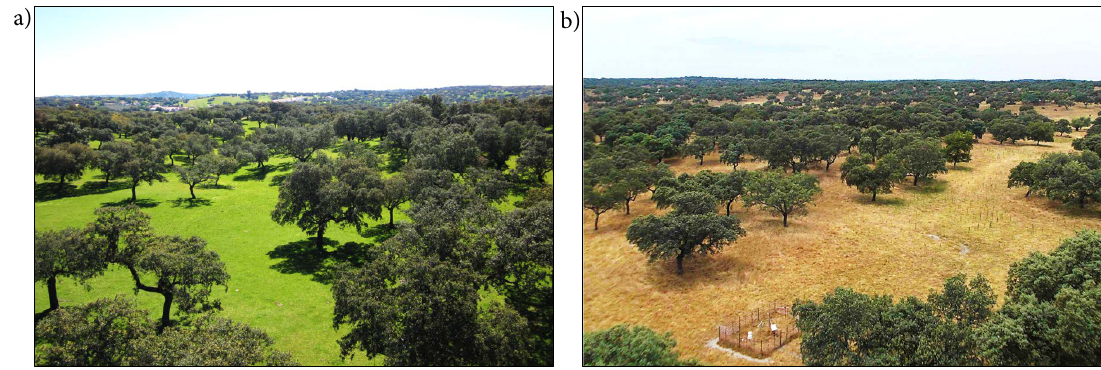
Figure 2. Pictures taken from the tower installed at the Santa Clotilde site in spring (7 April 2014) ( a ) and in summer (21 June 2013) ( b